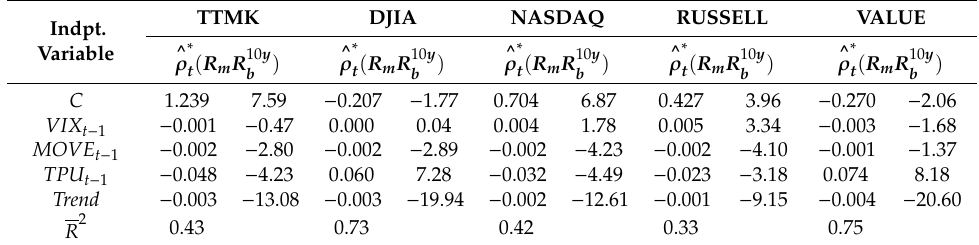
Table 9. Estimates of correlations of total stock market returns and 10-year bond returns in response to financial risk and total policy